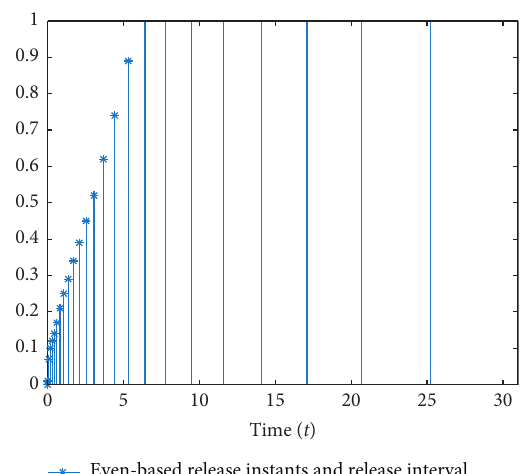
Figure 5: Event-triggered release instants and intervals of Theorem 1.